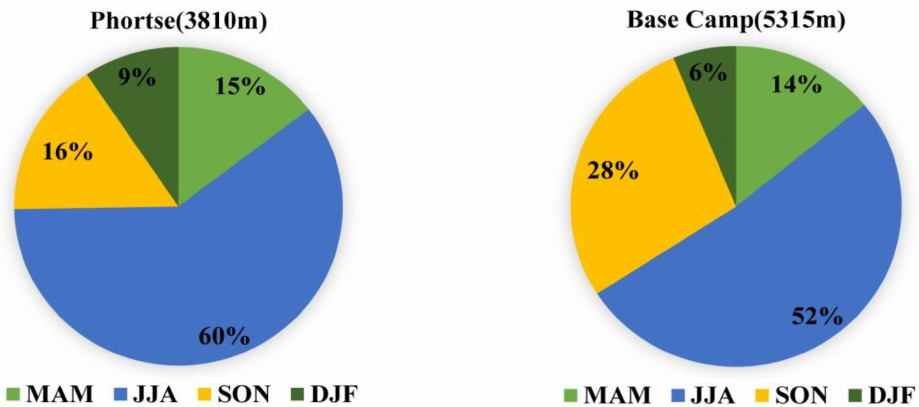
Figure 3. Seasonal variations of proportion of